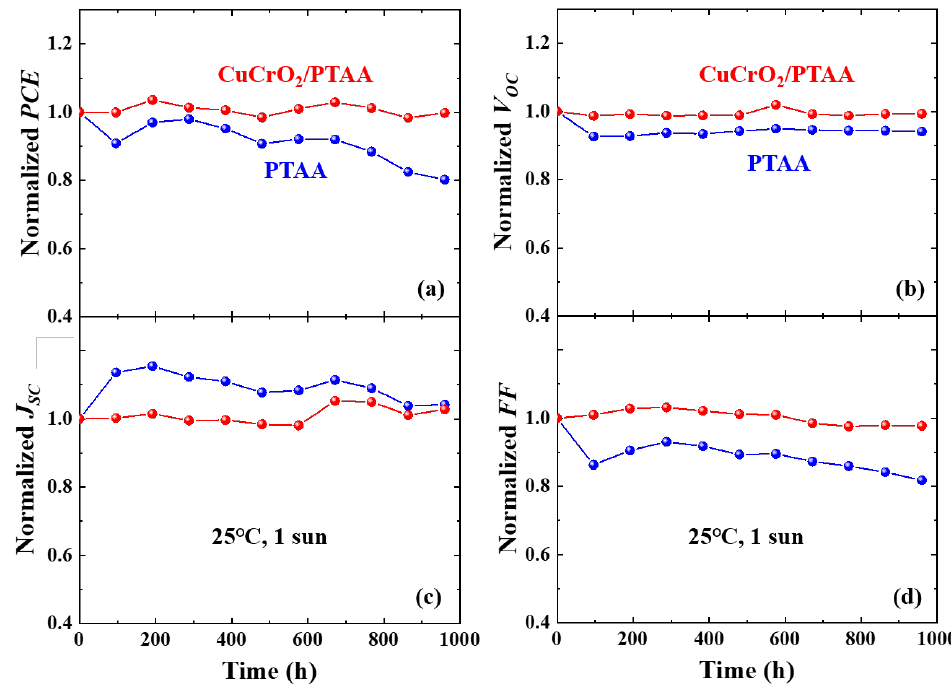
Figure 6. Light stabilities of solar cells with CuCrO 2 / PTAA or PTAA HTL: Normalized values of ( a ) efficiency, ( b ) V OC , ( c ) J SC , and ( d ) FF of the encapsulated solar cells obtained by maximum-power-point tracking (MPPT) under continuous illumination of AM 1.5G at 25 °C.